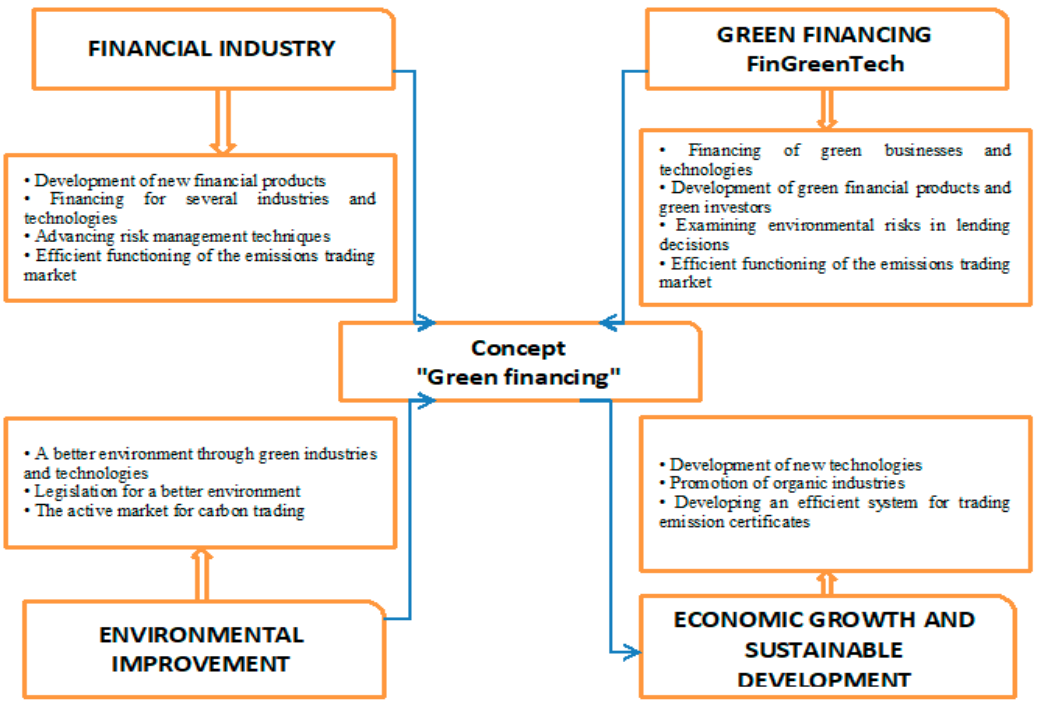
Figure 4. Theconceptof“GreenFinancing”andhowitconnectswiththebroaderfinancialindustry—using the FinGreenTech package as an Figure 4. The concept of “Green Financing” and how it connects with the broader financial industry— using the FinGreenTech package as an example.